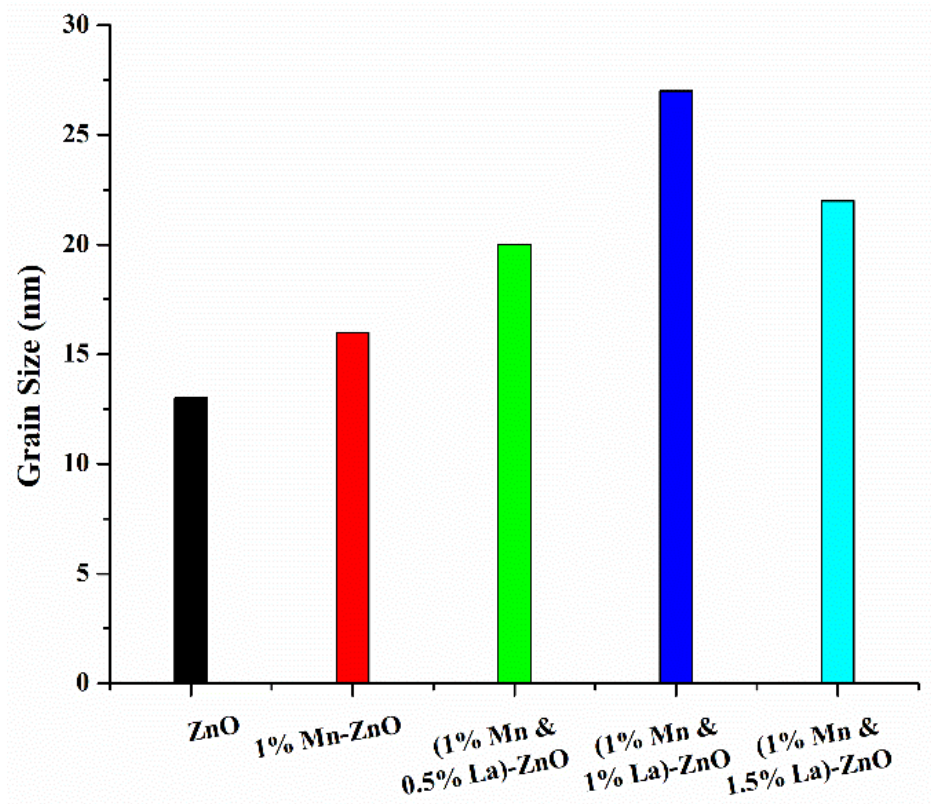
Figure 2. Graph of grain size based on the composition of thin